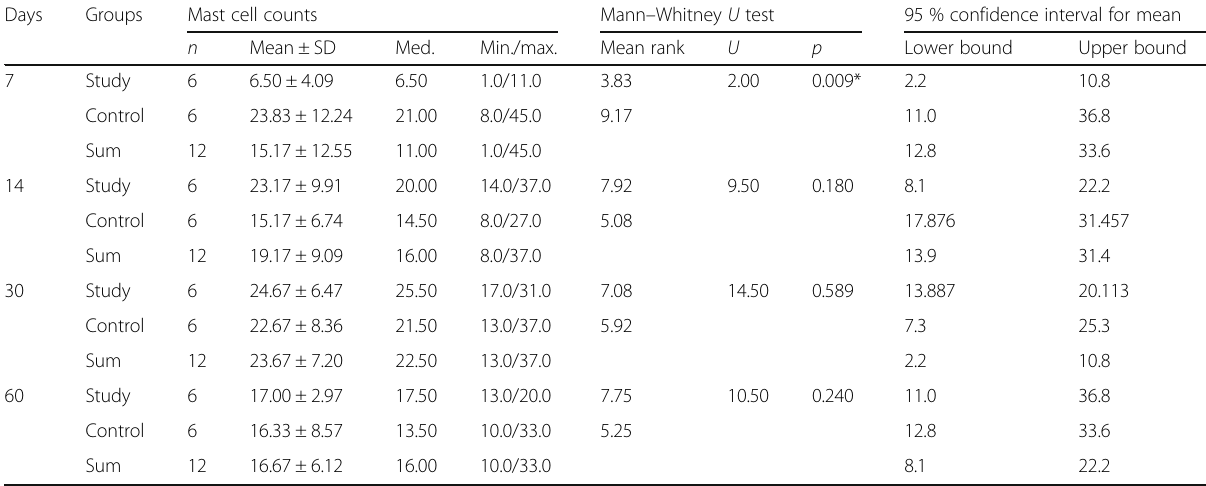
Table 1 Statistical comparison of groups for mast cell counts Days